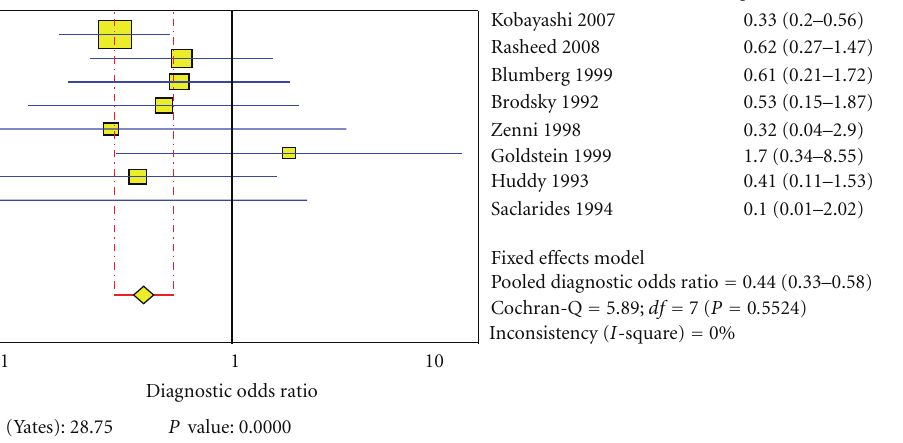
Figure 3: Risk of lymph node metastasis in T1 versus T2.